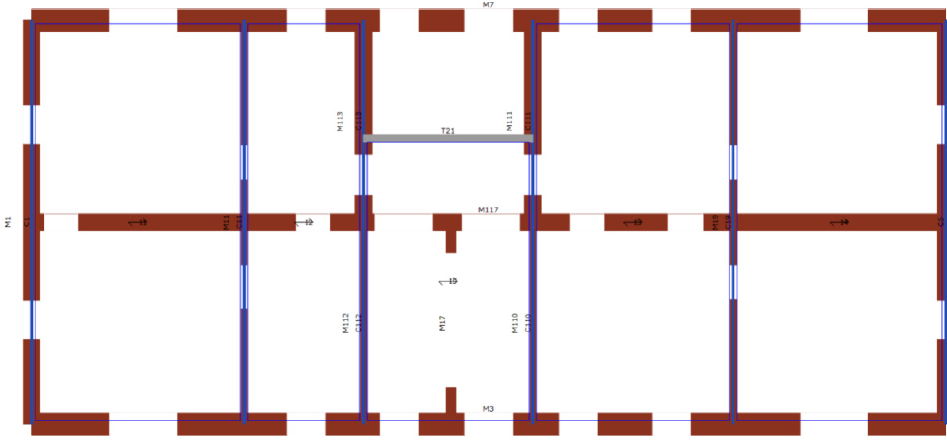
Figure 11. Ground floor plan.